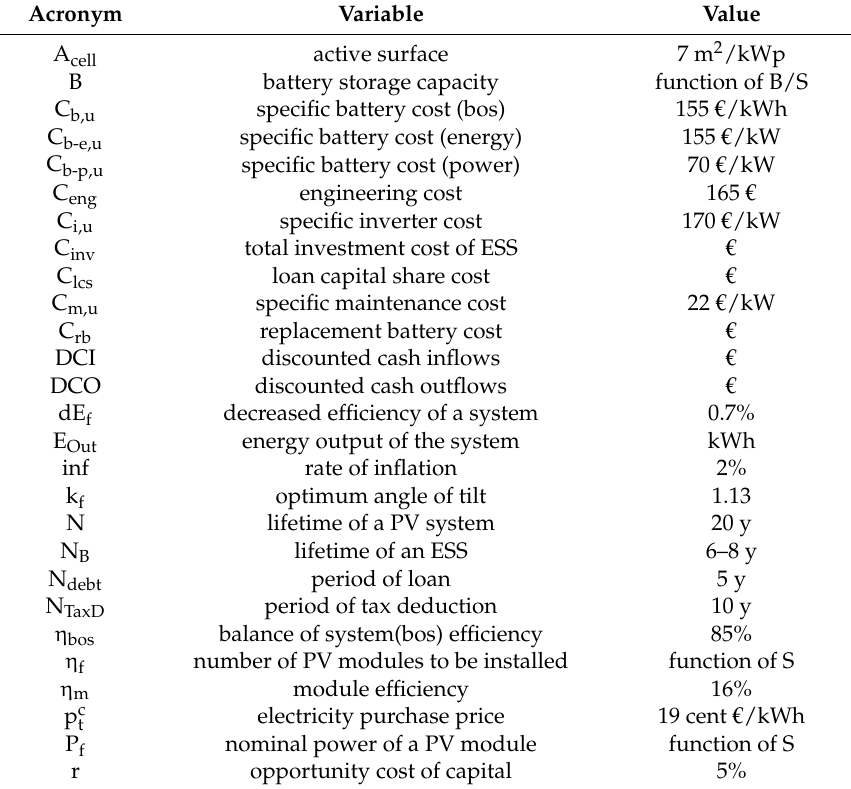
Table 1. Data inputs